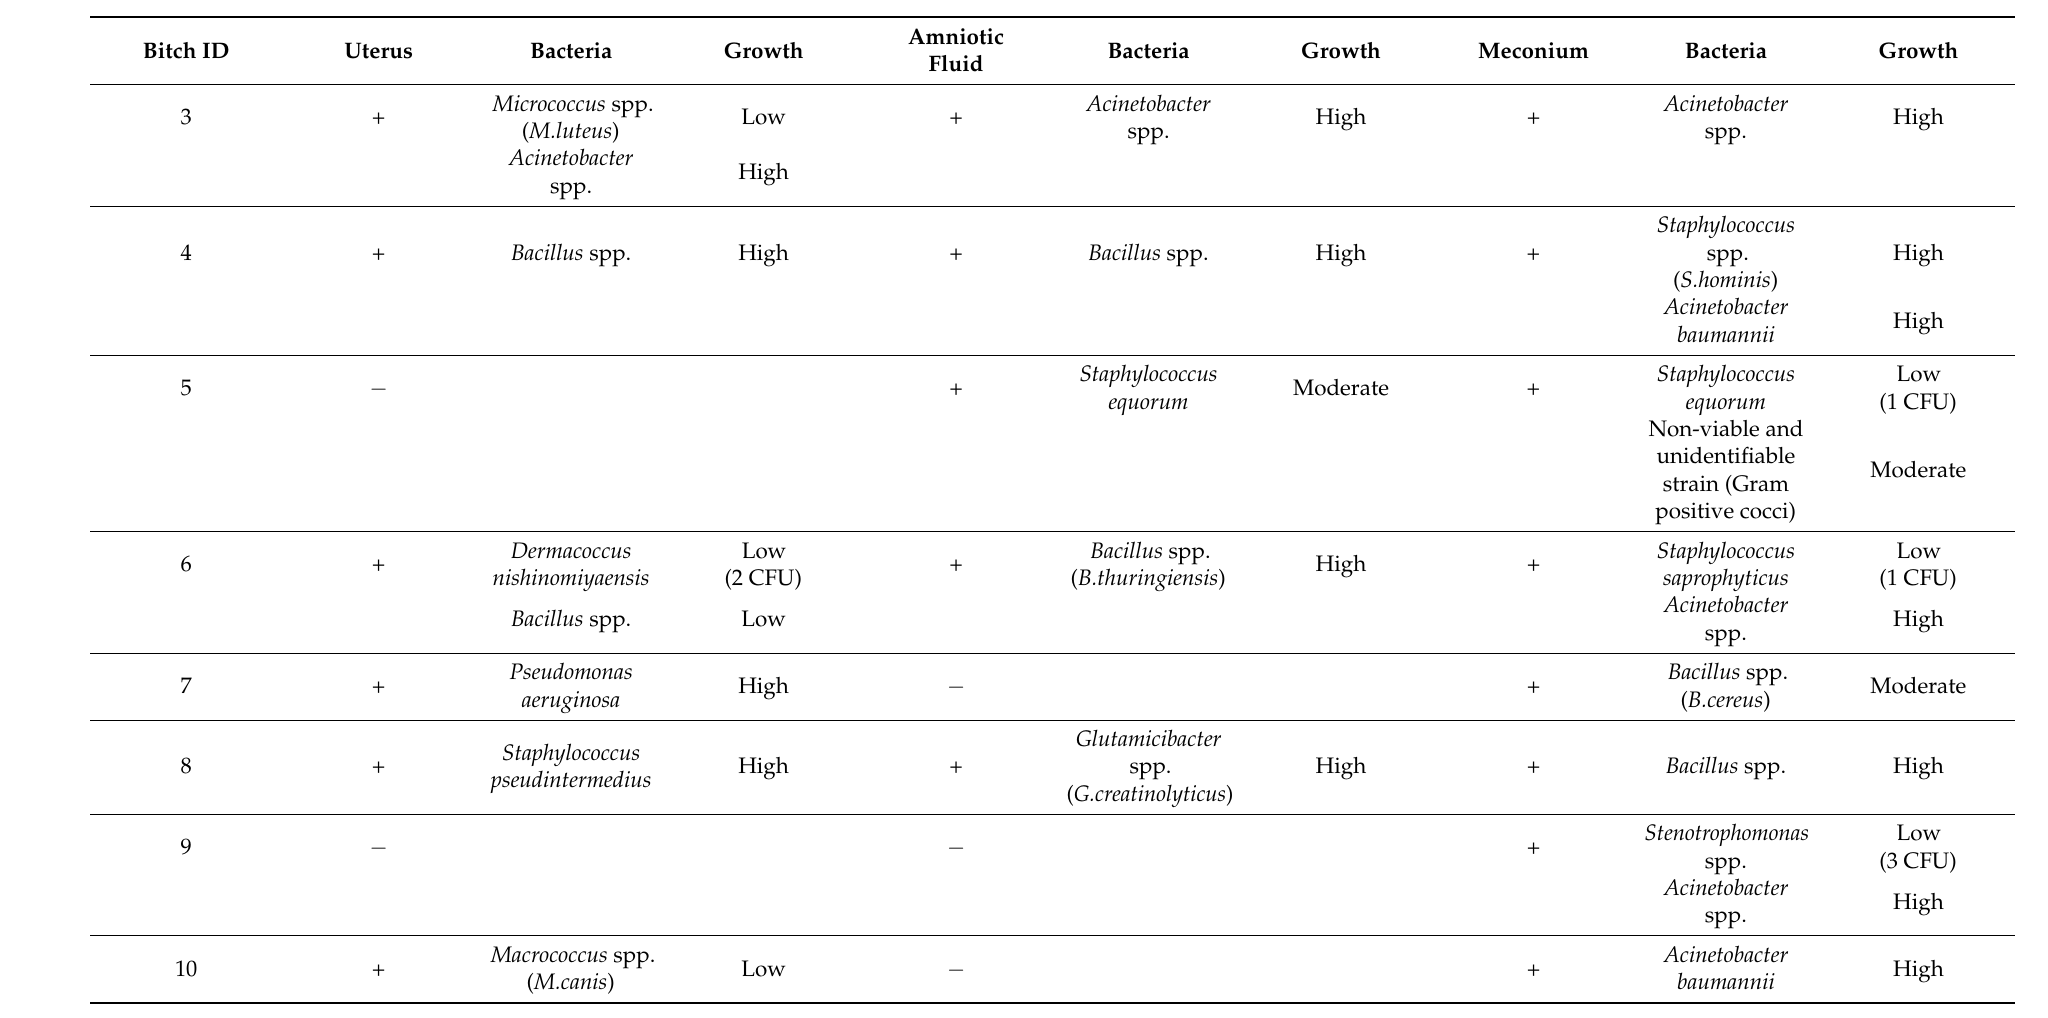
Table 3. Bacteria isolated from the three locations: uterus (site of placental insertion), amniotic fluid and meconium of the first extracted